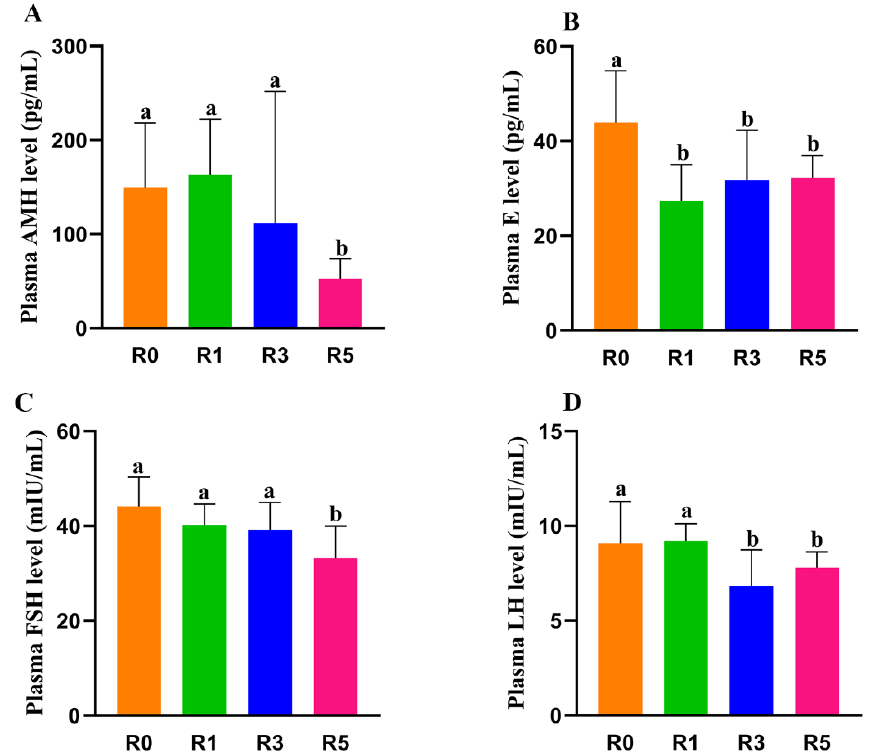
Figure 3. Plasma concentration of hormones. The plasma concentration of hormones was examined by ELISA. ( A ), AMH; ( B ), E (estradiol); ( C ), FSH; and ( D ), LH. The same letters mean the statistical difference was not significant between groups ( p > 0.05, unpaired t -test); different letters mean the statistical difference was significant between groups ( p < 0.05, unpaired t -test).